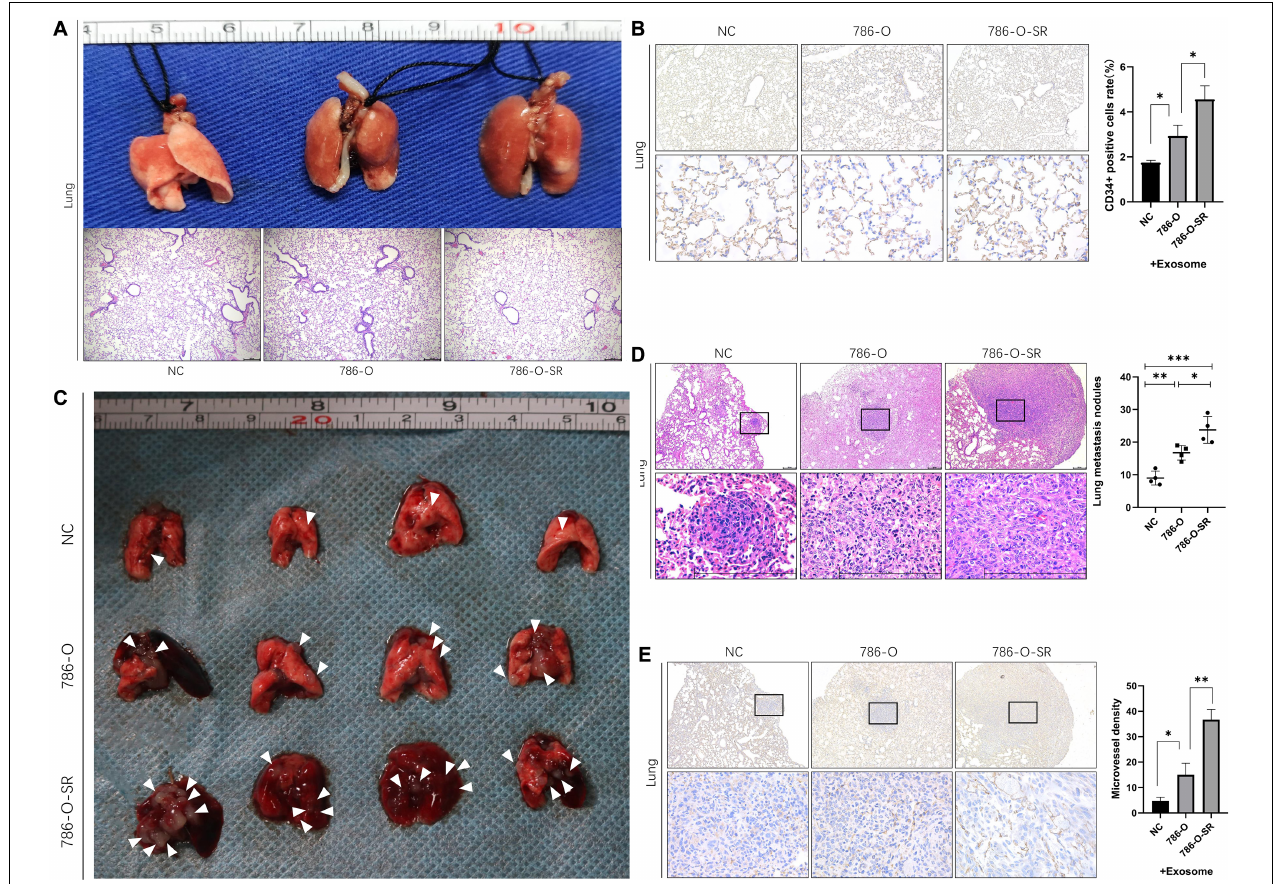
FIGURE 5 | Renal cancer exosomes promote ccRCC metastasis. (A) The mice were injected with 786-O cells via tail vein after exposure to 786-O or 786-O-SR exosomes. The lungs were removed for H&E staining after 15 days. (B) IHC staining for CD34-positive cells. Mean ± SEM are provided ( n = 3). (C) The lungs were removed after 30 days. Lung metastatic sites were indicated by arrows. (D) The number of lung metastatic sites was counted under the microscope. Mean ± SEM are provided ( n = 4). Scale bar 200 µ m. (E) Effect of exosomes of 786-O/786-O-SR on introtumoral microvessel density. The number of microvessel was counted under the microscope. Mean ± SEM are provided ( n = 3). ∗ P < 0.05, ∗∗ P < 0.01, ∗∗∗ P < 0.001 according to two-tailed Student’s t